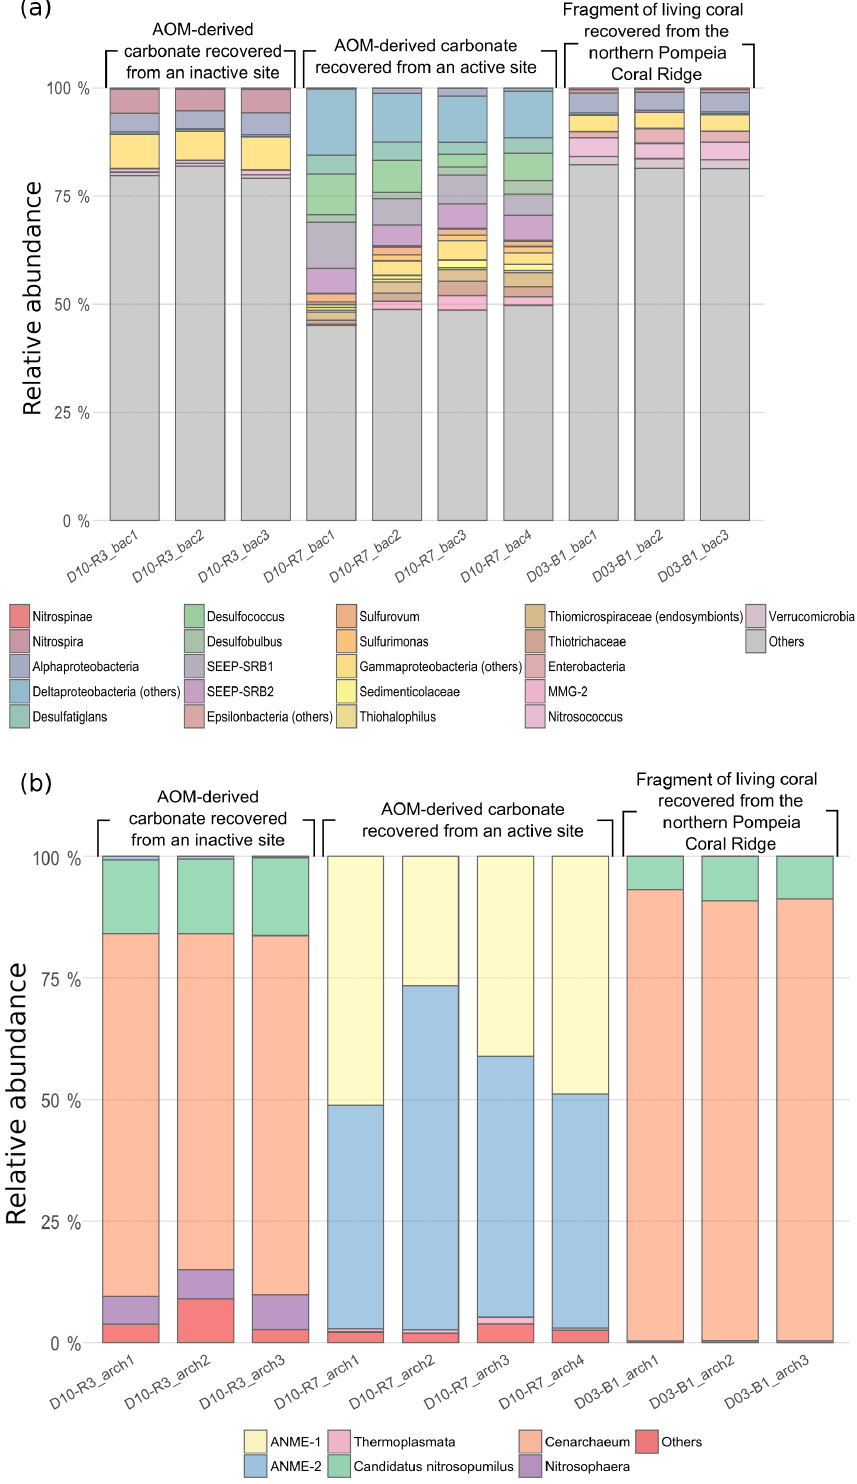
Figure 11. Bar chart representing relative abundances of prokaryotic taxa detected in each sample: (a) bacterial taxa and (b) archaeal taxa. In “others” an aggrupation of included taxa is related to ubiquitous organisms normally found in sea- and seepage-related environments and unclassified organisms. The number of reads per taxa is detailed in Table S1 (bacteria) and Table S2